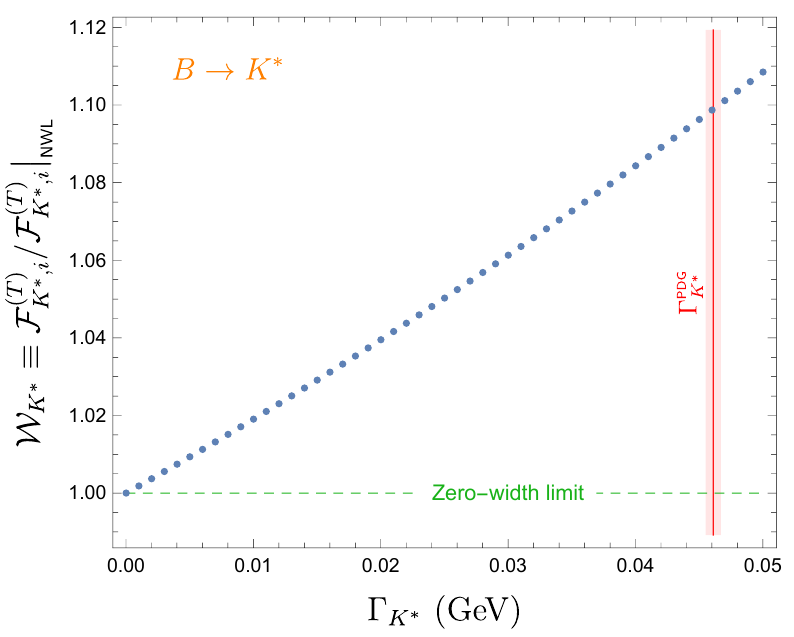
Figure 2 . Ratio W K (cid:3) quantifying the (cid:12)nite-width correction to the B ! K (cid:3) form factors, as a function of the K (cid:3) width (cid:0) K (cid:3) , for M 2 = 1 GeV 2 . The red vertical band corresponds to the physical width (PDG). This (cid:12)nite-width correction is universal and q 2